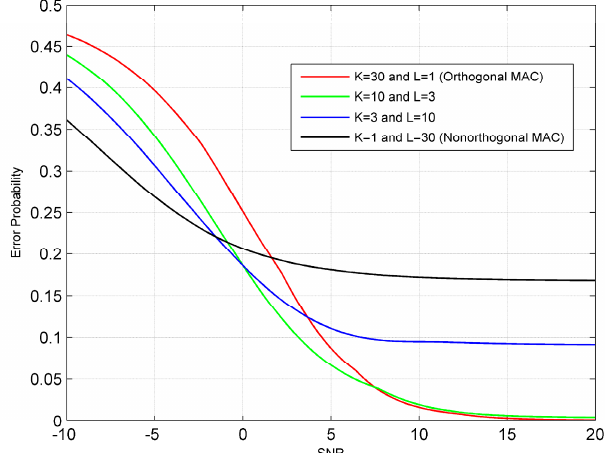
Figure 5. The error probability as a function of channel SNR for the TS fusion rule.